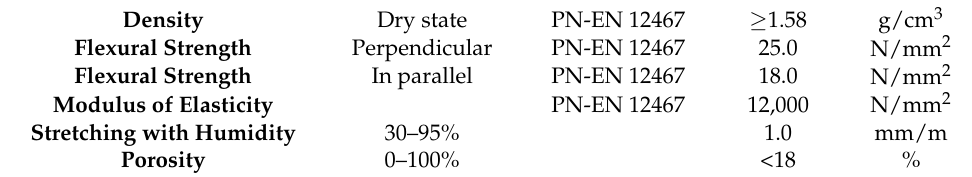
Table 1. The declared average technical parameters of the